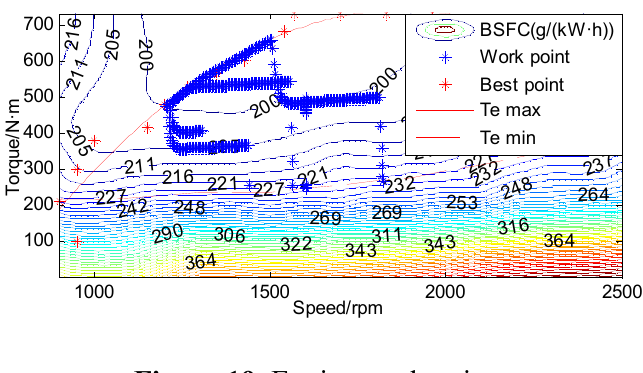
Figure 19. Engine work points.